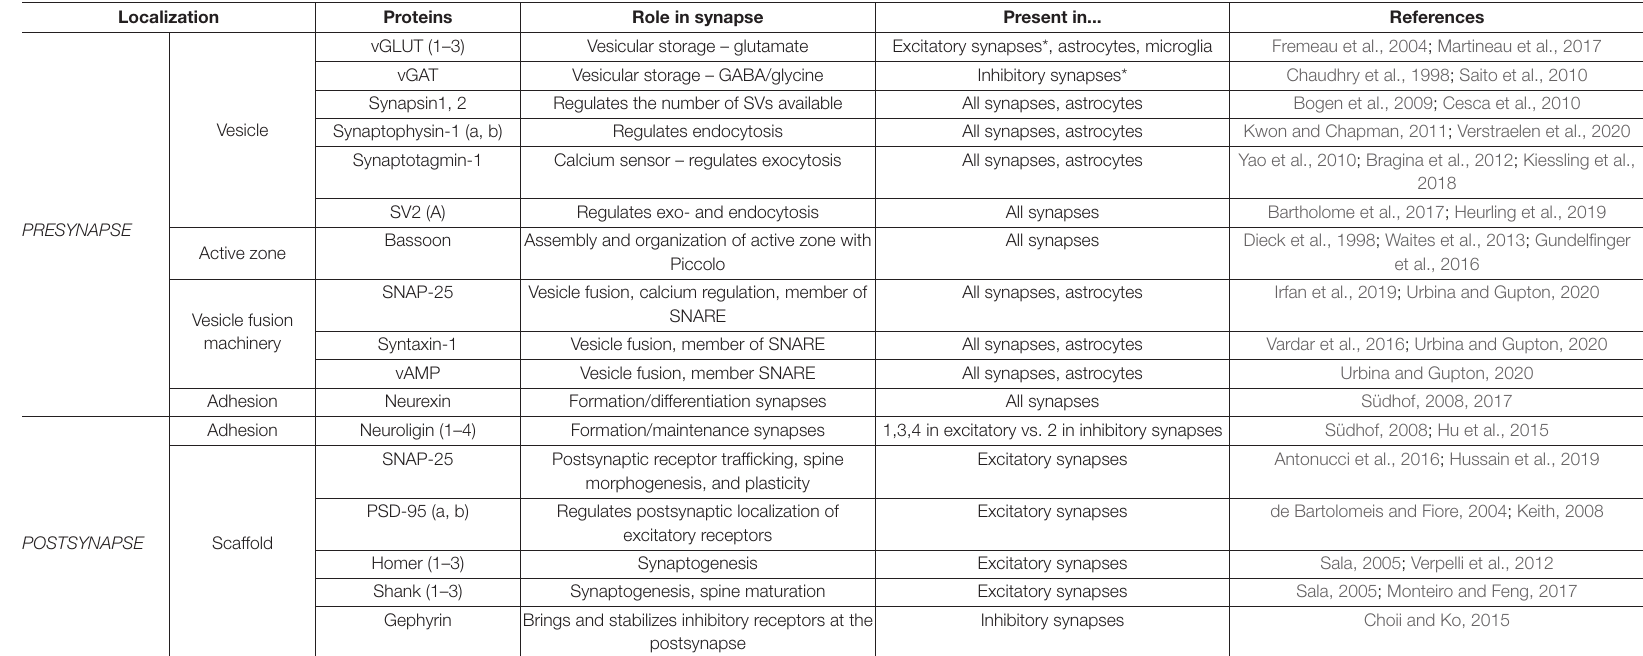
TABLE 1 | Main pre- and post-synaptic proteins used as synaptic density